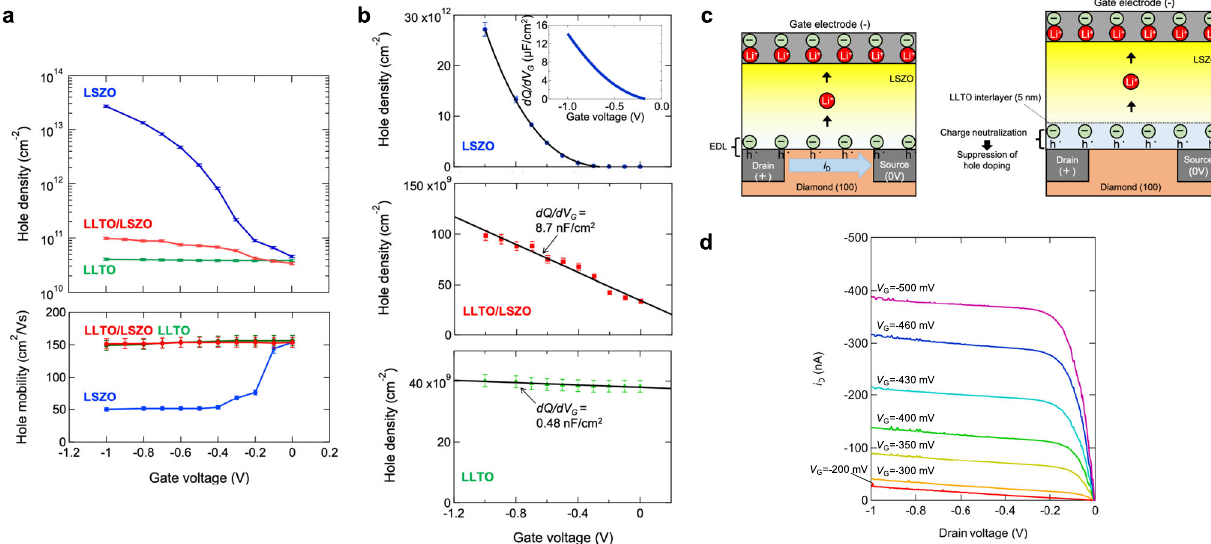
Fig. 2 Hall measurement of H-diamond-based EDLTs. a Variation in hole density (upper panel) and hole mobility (lower panel) for H-diamond (100)- based EDLTs consisting of LSZO, LLTO/LSZO, and LLTO electrolytes determined by Hall measurements. b Linear plot of the variation in hole density shown in Fig. 2a. c Illustrations of the difference in hole density modulation behaviors in LSZO and LLTO/LSZO devices. Li + in the electrolytes is depicted only for indicating polarity of electric current. d i D vs. V D characteristic of the LSZO device. Error bars in the fi gure represent